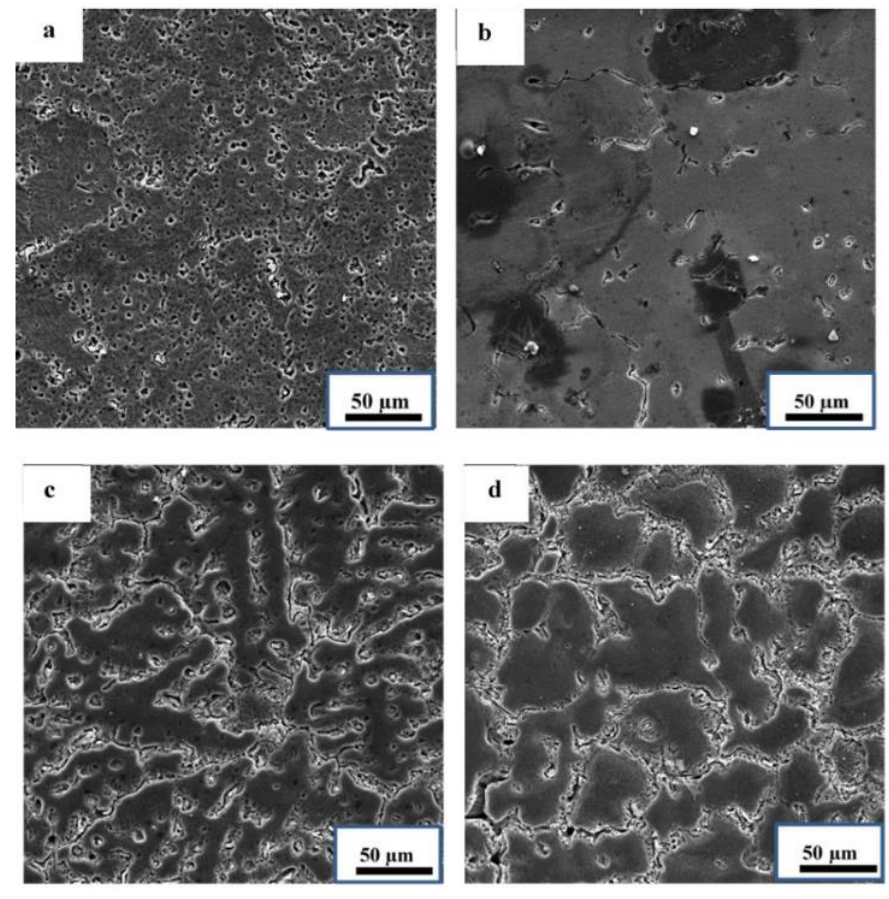
Fig. 3. SEM micrographs of Al 7075 and Al 7075 –TiC composites (a) Al 7075 Alloy (as received, hot extruded ); (b) Al 7075-3 wt.% TiC; (c) Al 7075-6 wt.% TiC; (d) Al 7075-9 wt.% TiC composites. Fig. 4(a)-(b) shows the SEM image and the corresponding EDS spectrum of the Al 7075 in the as-received or the hot extruded condition. The EDS spectrum of the Al 7075 in hot extruded alloy revealed the presence of Al, Mg, Cu and Zn. Fig. 5 (a) & (b) shows the SEM image and the elemental mapping of as received Al 7075-6 wt.% TiC. Furthermore, the EDS mapping indicated the distribution of Ti throughout the grain boundary and also the precipitates were rich in Cu and